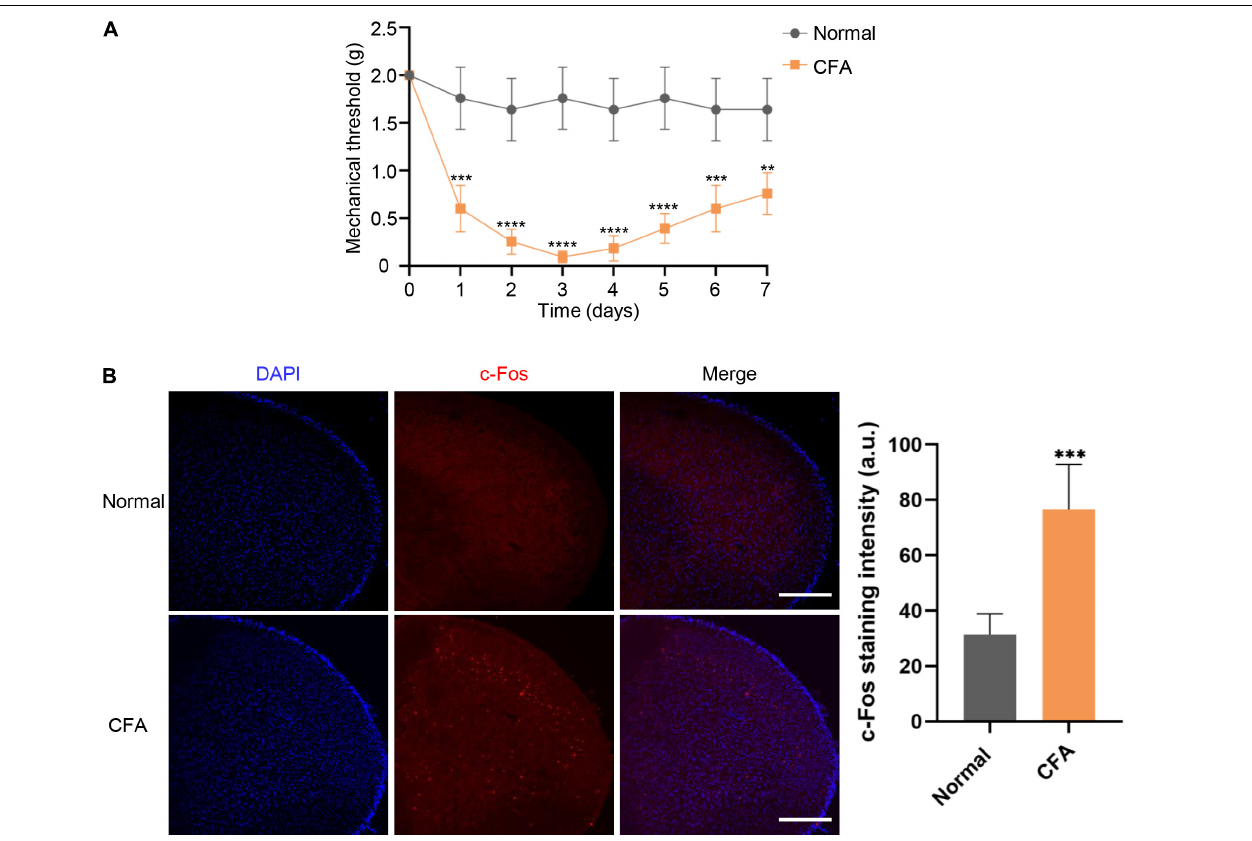
FIGURE 1 | Mechanical thresholds and c-Fos expression in STN following CFA injection. (A) Changes in mechanical thresholds of mice before and 7 days after CFA injection. Mean ± SD, n = 6, ** P < 0.01, *** P < 0.001, **** P < 0.0001. Data were analyzed by repeated measures ANOVA. (B) The c-Fos expression alteration in STN under normal and orofacial inflammatory pain conditions. Compared with normal group, the expression level of c-Fos protein in experimental group was significantly increased at 7 days after CFA injection. The blue fluorescence represents DAPI while red fluorescence represents c-Fos. Data were analyzed by unpaired t -test. *** P < 0.001, Scale bar = 300 µ m. STN, spinal trigeminal nucleus; CFA, complete Freund’s